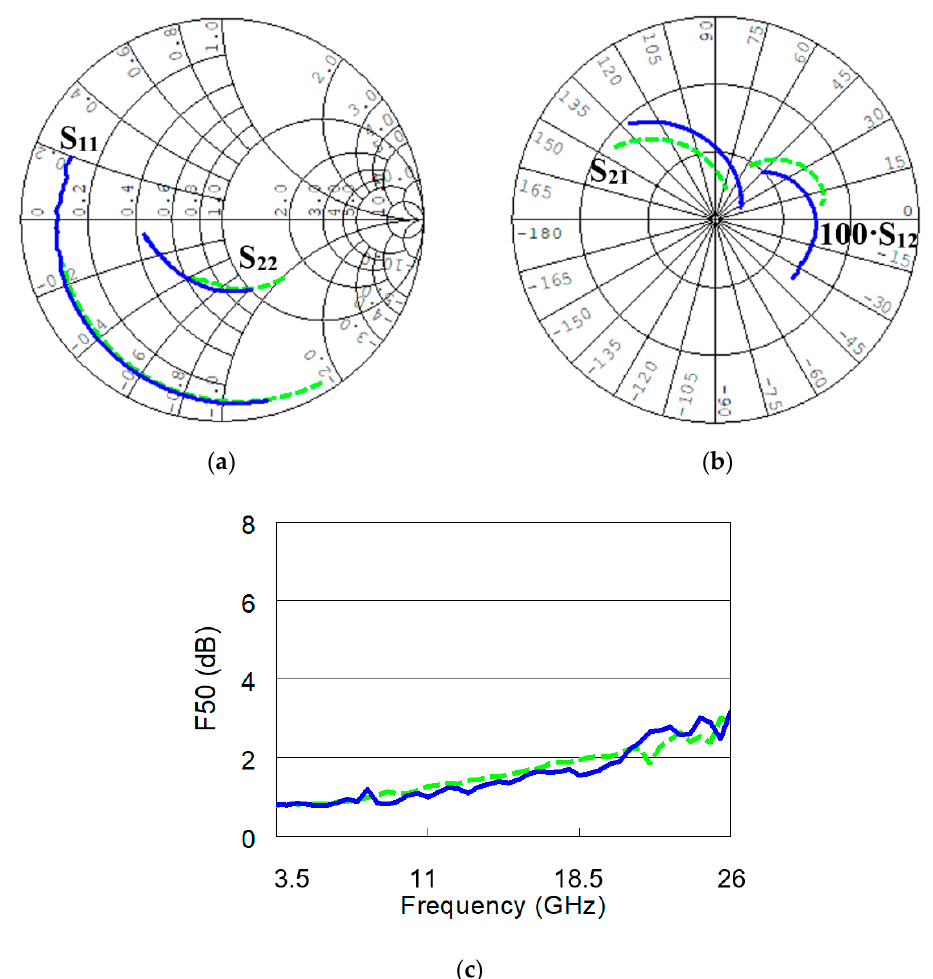
Figure 8. Scattering parameters measured by NRL (green dashed line) and UniME (blue solid line) for a HEMT with gate width of 6 × 50 μ m (3.5–26 GHz). ( a ) S 11 and S 22 , ( b ) S 21 and 100 · S 12 , ( c ) F 50 . V DS = 2 V and I DS = 60 mA.